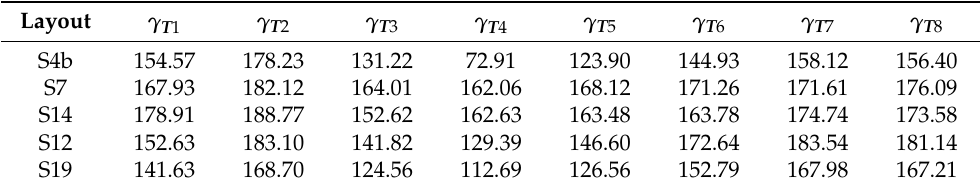
Table 5. Values of γ for the different layouts in eight repeated experimental tests for the second experimental